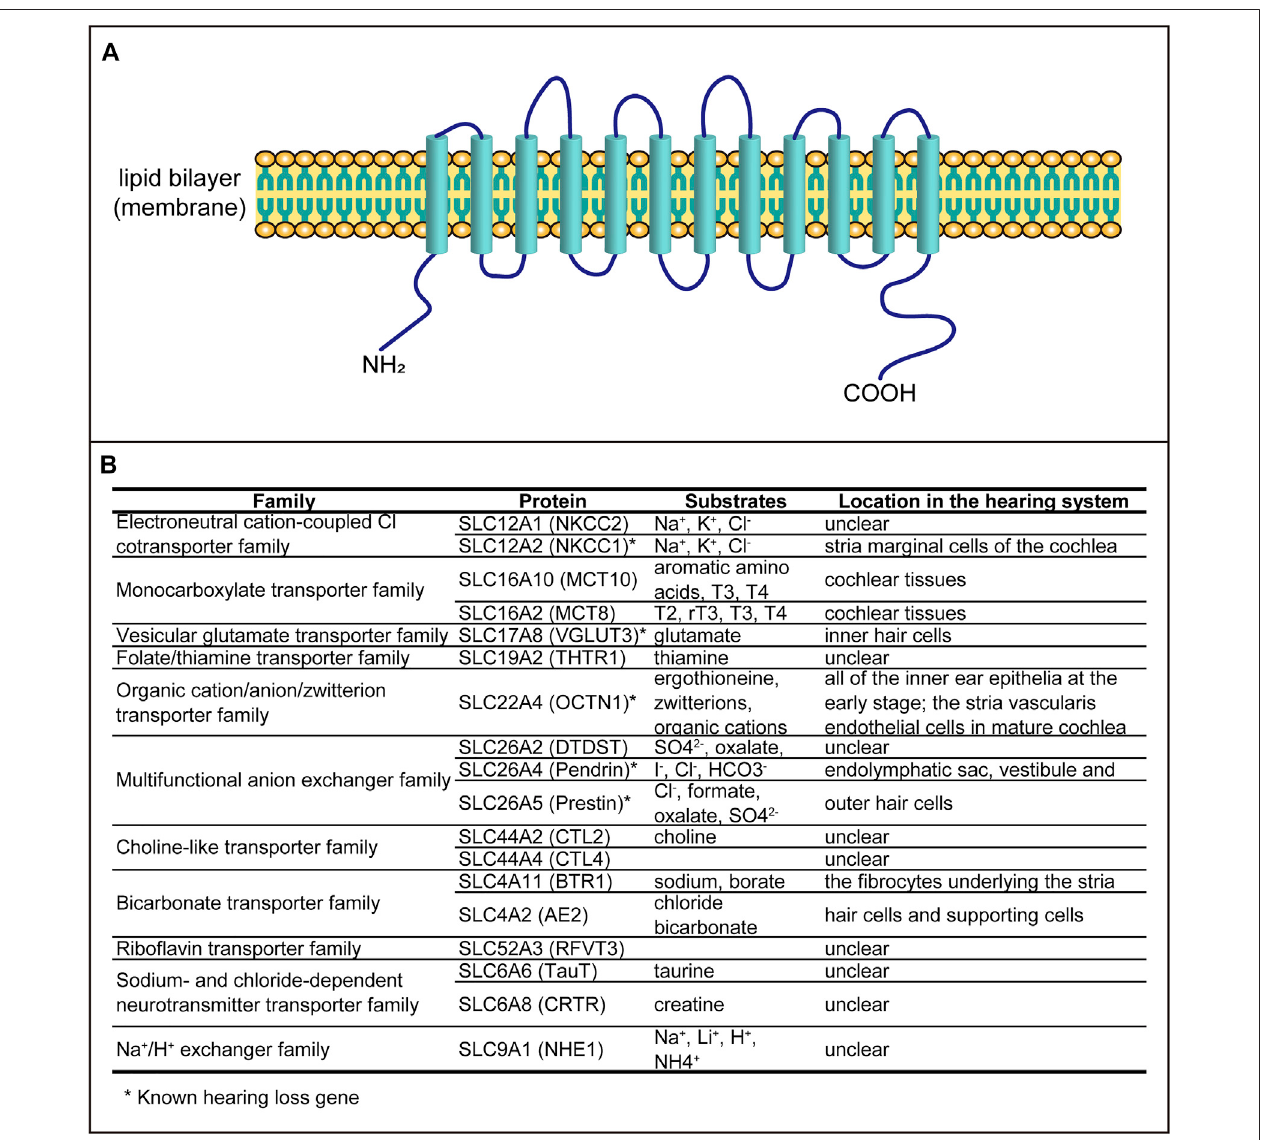
Frontiers in Genetics |